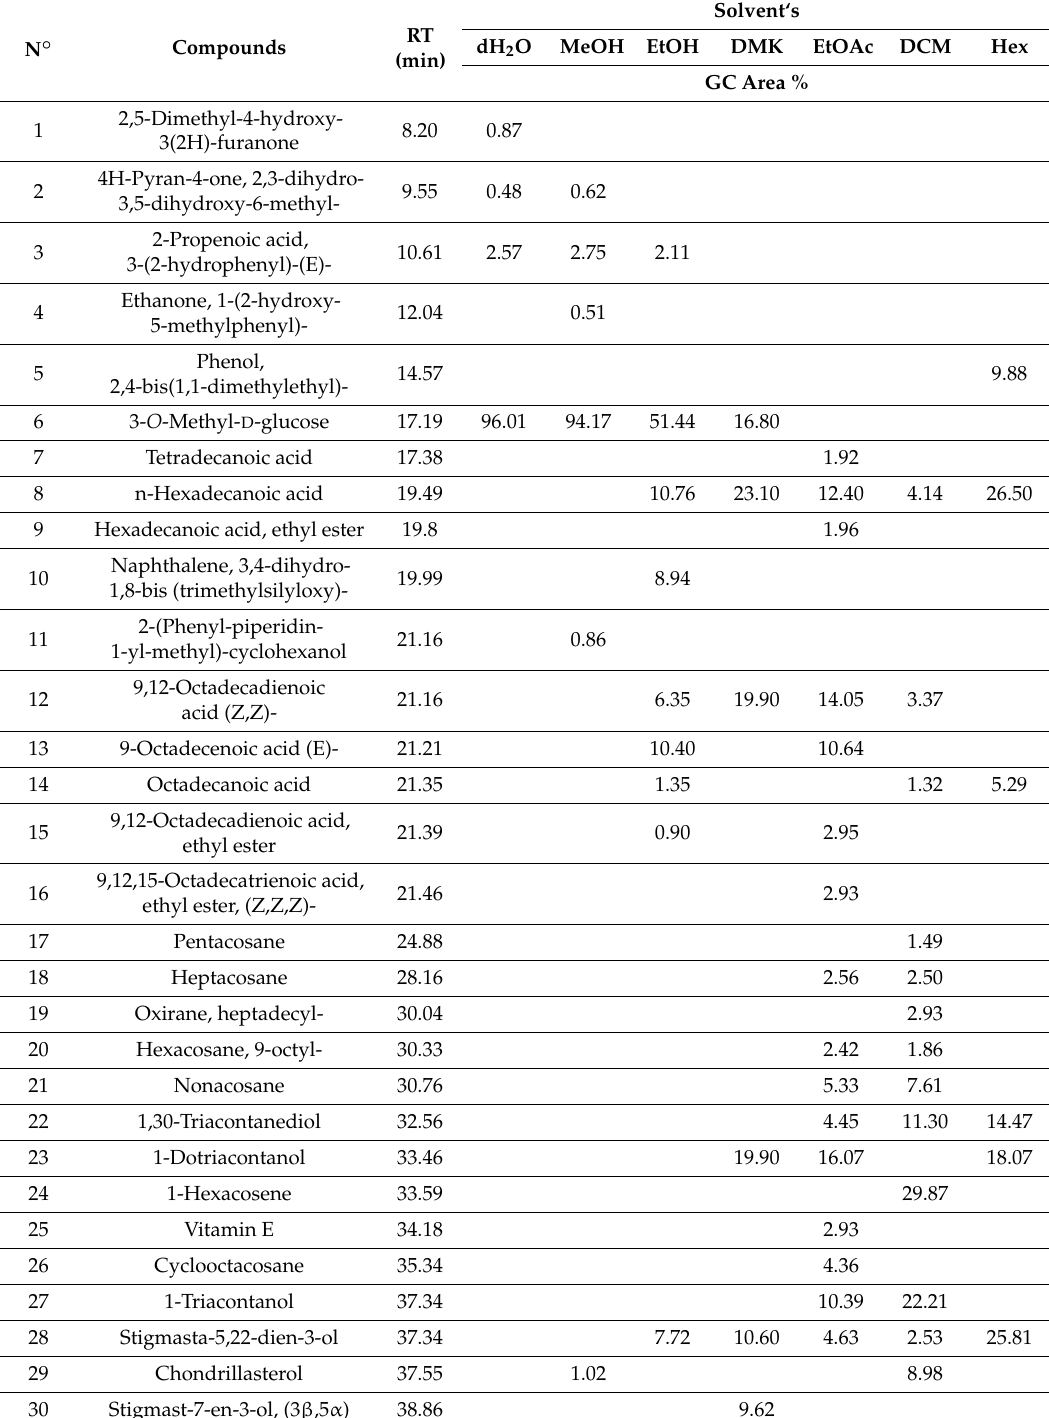
Table 3. Compounds present in different solvent